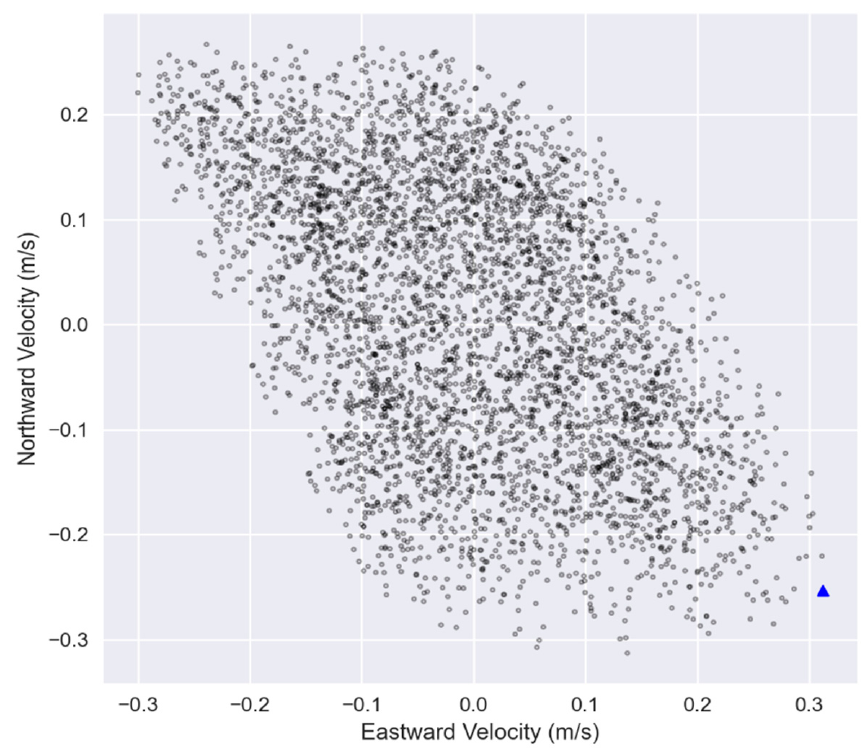
Figure 3. The scatter plot of the hourly model bottom currents at a CPZ vertex (triangle, Figure 1) of the northern reef for half a year. The maximum hourly current is depicted by the blue triangle.